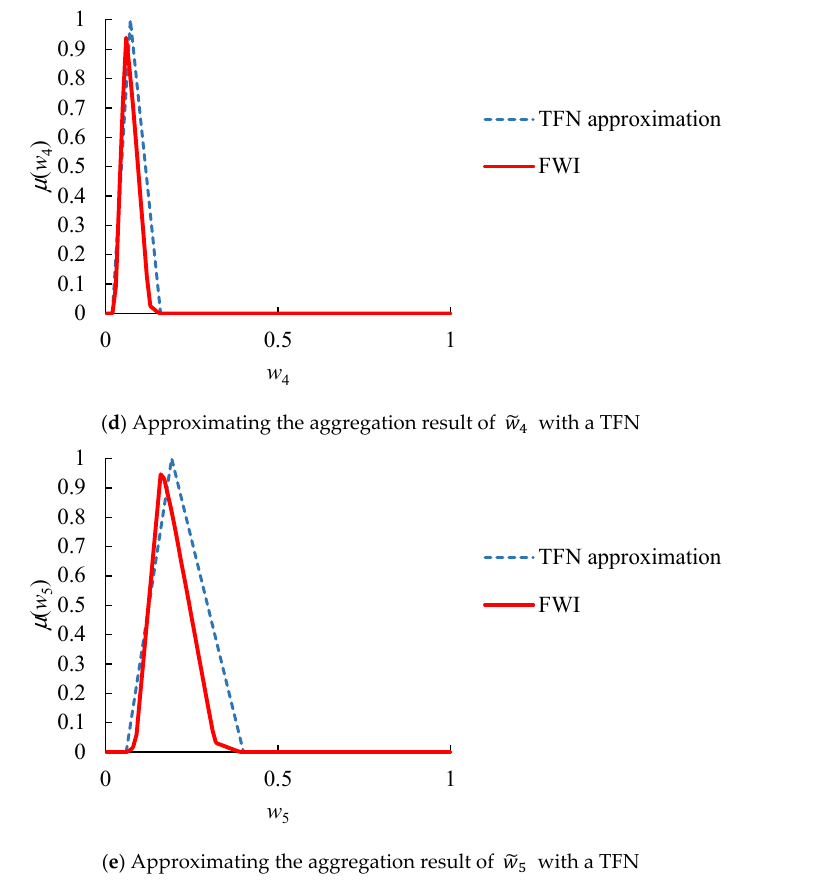
Figure 7. Approximating the aggregation result with a TFN.